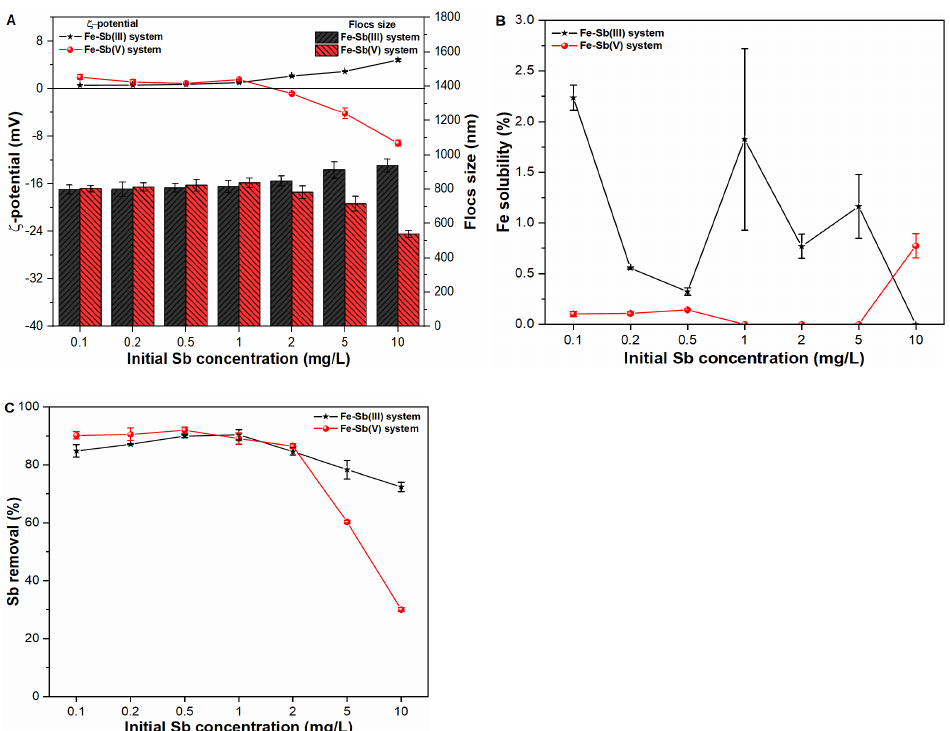
Figure 4. Influence of contaminant loading on ( A ) zeta potential (mV) and size (nm) of freshly formed Fe flocs; ( B ) Fe solubility (%) and; ( C ) Sb removal (%) in Sb(III, V) suspensions.